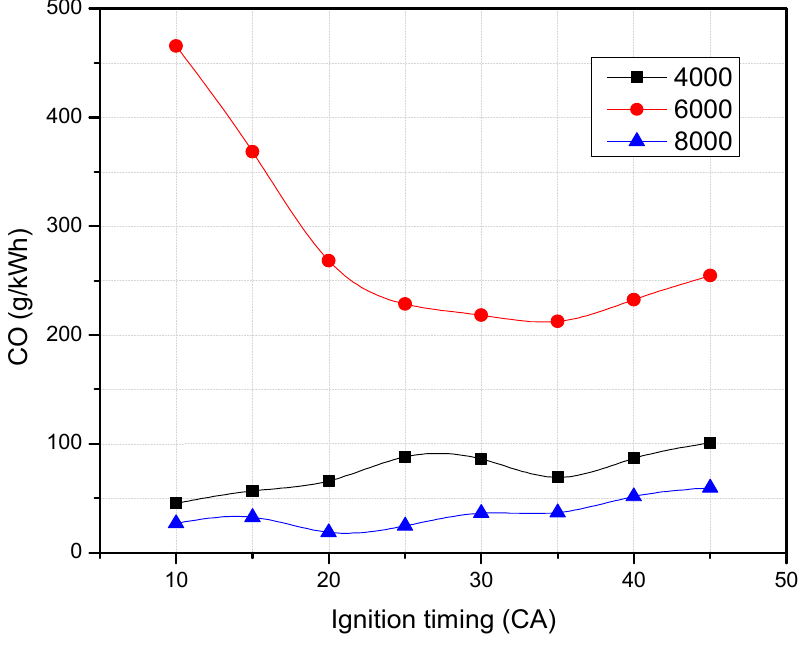
Figure 19. CO emissions versus ignition timing.